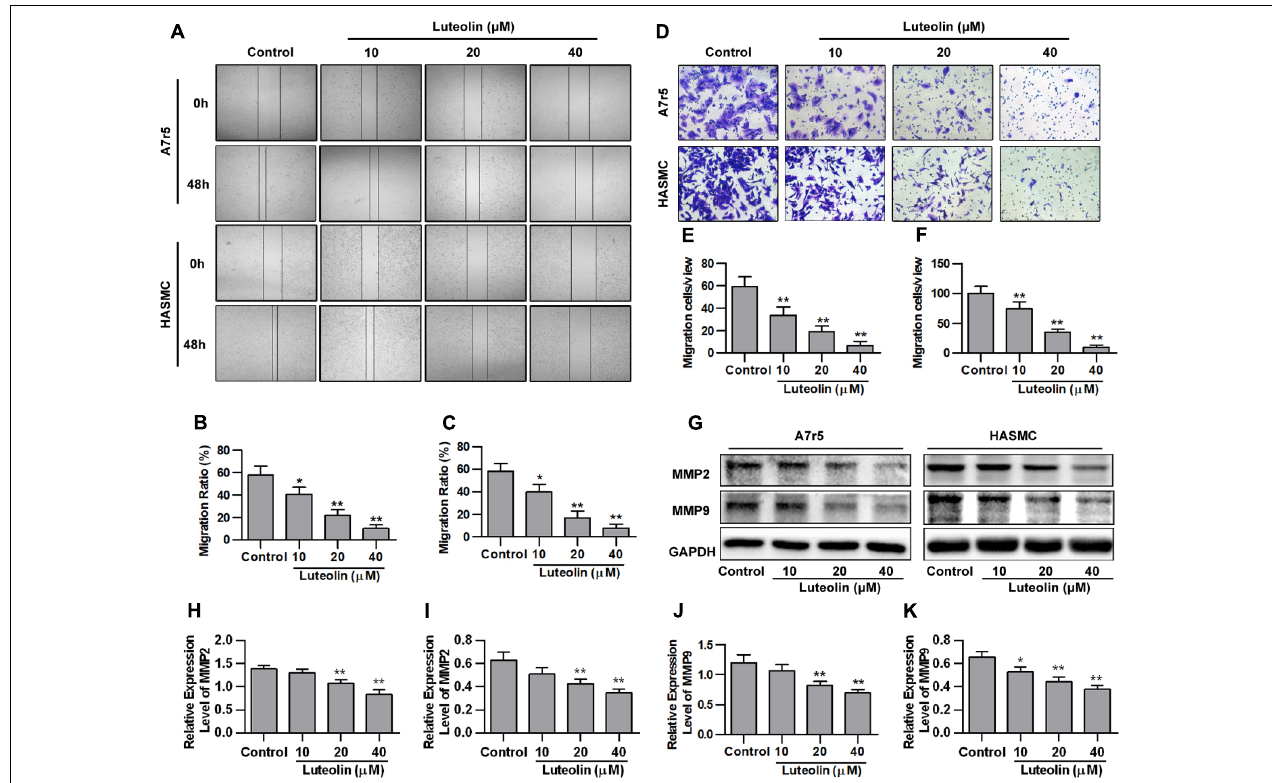
FIGURE 2 | Luteolin suppresses the migration of vascular smooth muscle cells (VSMCs). (A) A7r5 and HASMC cells were incubated with different concentrations of luteolin (10, 20, and 40 µ M) for 24 h, and the migration of VSMCs was tested by wound healing assays; the migration distance was estimated based on the width of the scrape at 0 and 48 h. (B , C) Percentage of relative VSMC migration ( n = 3). (D) A7r5 and HASMC cells were harvested in the logarithmic growth phase, treated with different concentrations of luteolin (10, 20, and 40 µ M), and tested by performing Transwell assays for 12 h. (E , F) The number of cells in each field of view ( n = 5). (G) A7r5 and HASMC cells, respectively, were incubated with luteolin (10, 20, and 40 µ M) for 24 h, and the expression levels of MMP2 and MMP9 were tested by western blotting. (H – K) Relative expression levels of MMP2 and MMP9 ( n = 3). Data are presented as the mean ± SD. ∗ P < 0.05, ∗∗ P < 0.01, compared to the control